Question: Author a descriptive caption for the visualization shown.
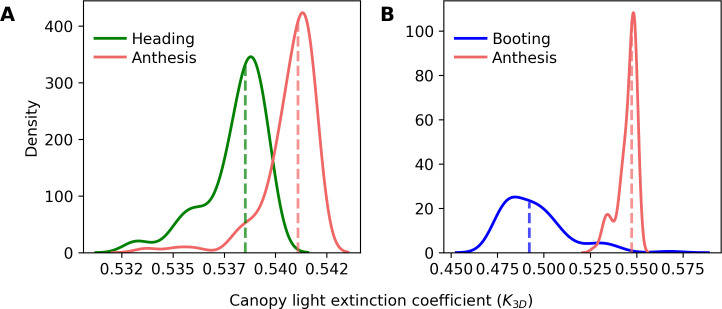
Answer: Canopy light extinction coefficient at two growth stages [heading and anthesis in 2022 (A) and booting and anthesis in 2023 (B) ]. The vertical dotted line represents the median value of all genotypes.